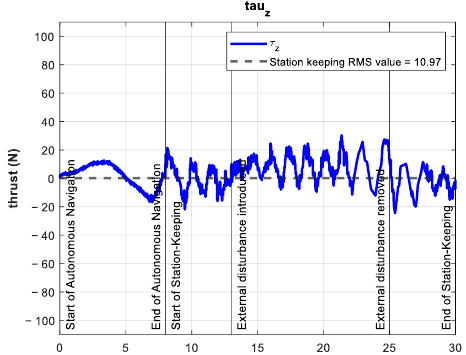
external disturbance.